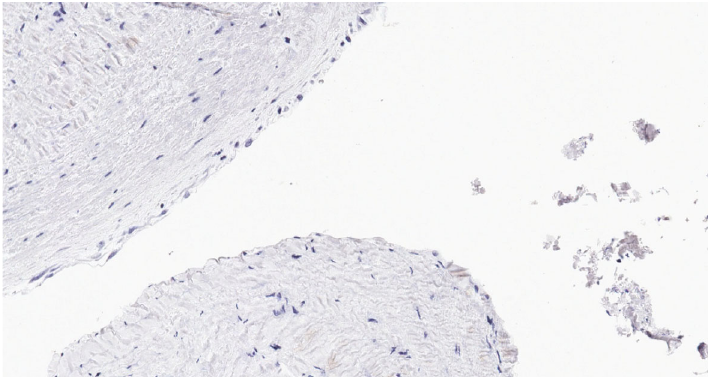
Figure 6: Negative staining of Calretinin rejects the diagnosis of the mesothelial